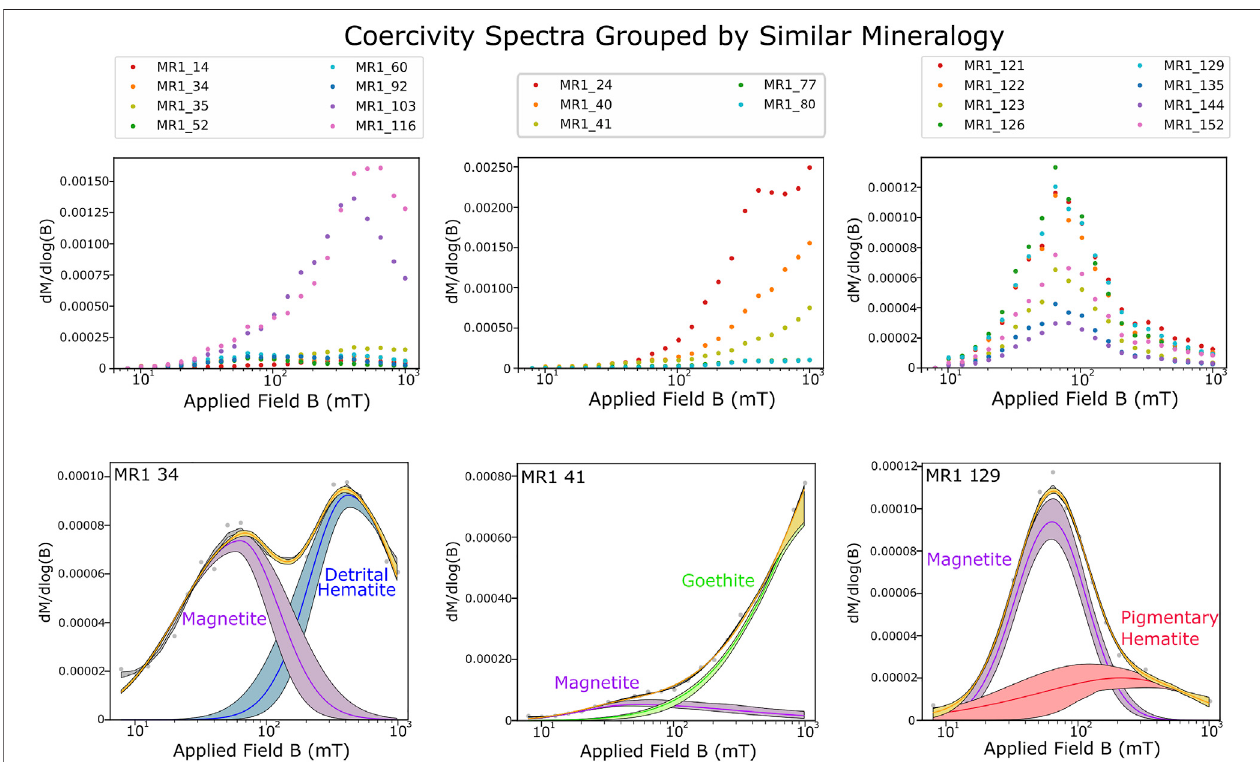
FIGURE 2 | Coercivity spectra and unmixed magnetic components for selected MR1 samples. Rock magnetic data were collected for 21 samples from the MR1 core(forstratigraphiclocation,see Figure4 ).Theunscaledcoercivityspectraforthosesamplesareshownhere,separatedbymineralogy,withdetritalhematite-bearing samples on the left, goethite-bearing samples in the center , and pigmentary hematite-bearing samples on the right . The three samples that contain both detrital hematite and goethite are included in the goethite column. Below each coercivity spectra isa representative plot of the magnetic mineral components contained in those samples, made using MAX UnMix (Maxbauer et al., 2016). Eleven samples contain detrital hematite, fi ve have goethite, eight have pigmentary hematite, and 20 have magnetite. Each sample contains some combination of two or three of these magnetic minerals, as shown in the MAX UnMix representative plots. Some of the peaks labelled as magnetite could instead be attributed to pyrrhotite based on the demagnetization data.